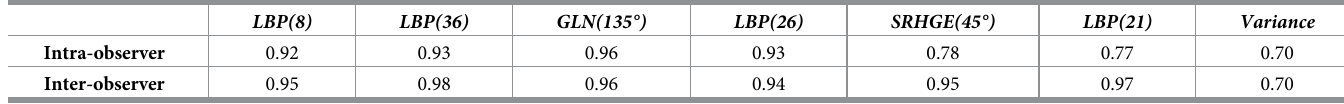
Table 5. Intra-class correlation coefficients (ICC) for the intra- and inter-observer reproducibility of the pattern-derived texture